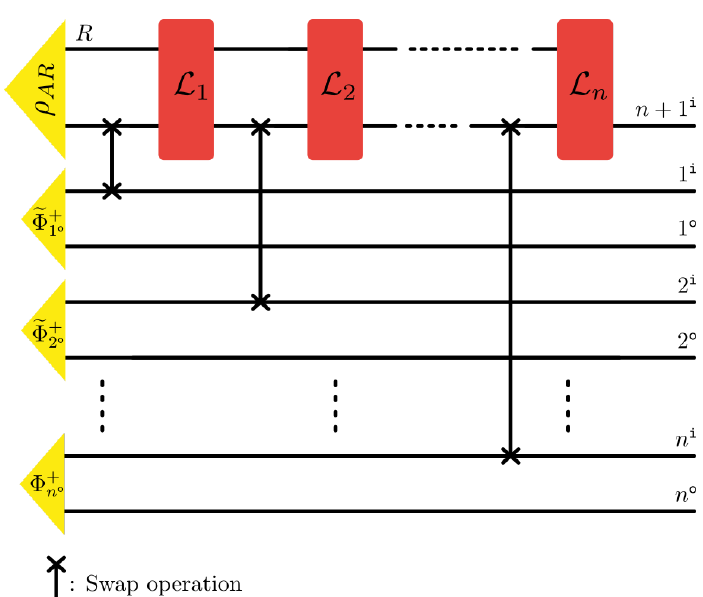
Figure 13: CJI for combs. At each time t , one half of a maximally entangled j state it fed / swapped into the process. The resulting multipartite quantum state Υ (cid:48) ∈ B ( H i ⊗ H o ⊗ ··· ⊗ H o ⊗ H i ) contains all spatio-temporal correlations n + 1 n n + 1 1 1